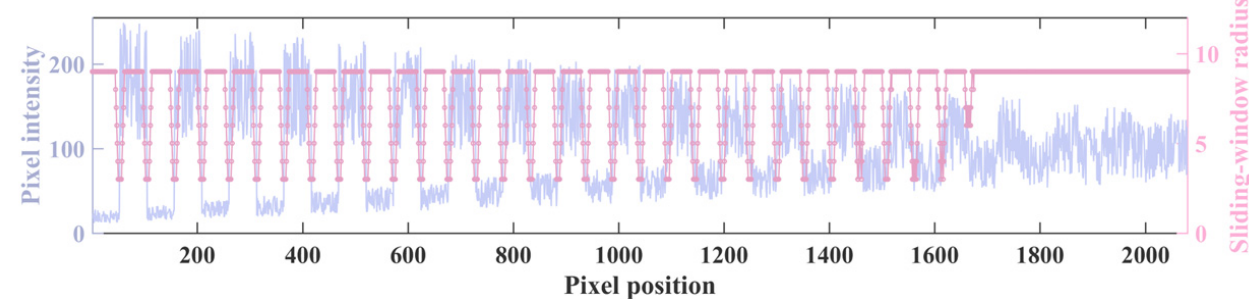
Figure 9. The experimental result for response sensitivity.